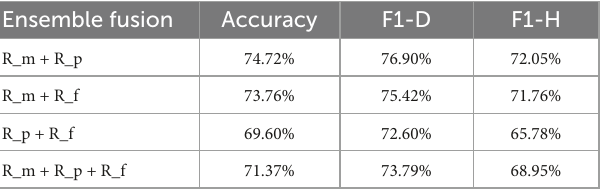
TABLE 8 Performance of ensemble fusion system of Resnet x-vectors based on different feature sets.